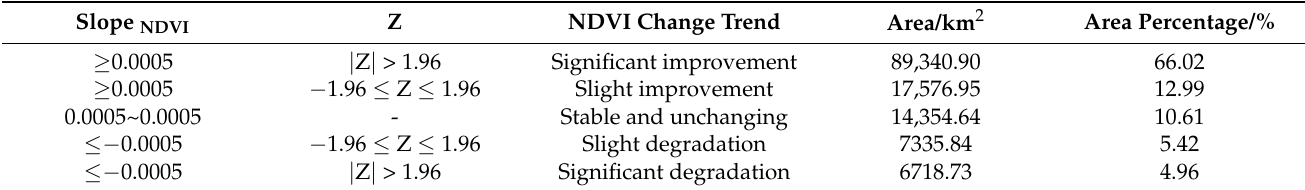
Table 2. Classification table of NDVI change trend from 2001 to 2020. Figure 4. Spatial distribution of Theil–Sen slope of average NDVI in the growing season in the Minjiang River Basin from 2001 to 2020 and the superposition result with Mann–Kendall test.